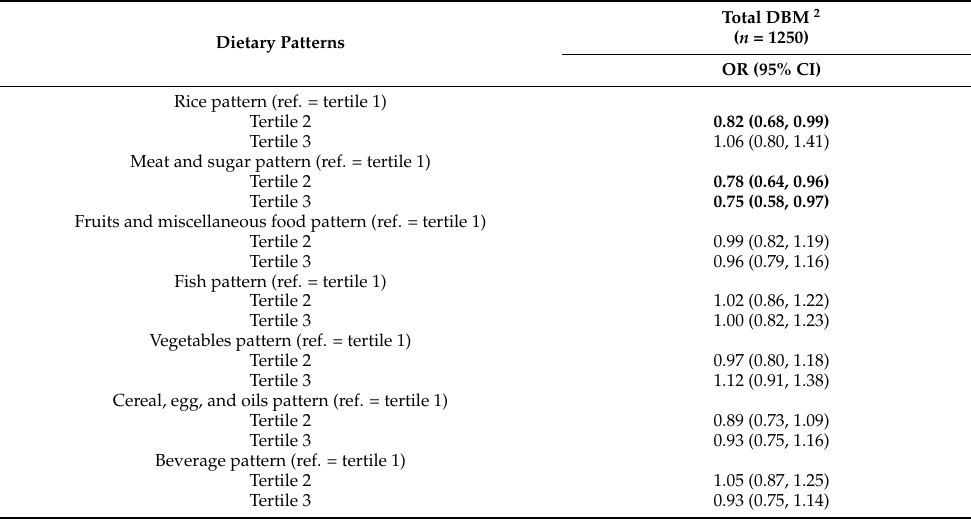
Table 5. Logistic regression models for double burden of malnutrition across tertiles of dietary pattern scores among males 1 .